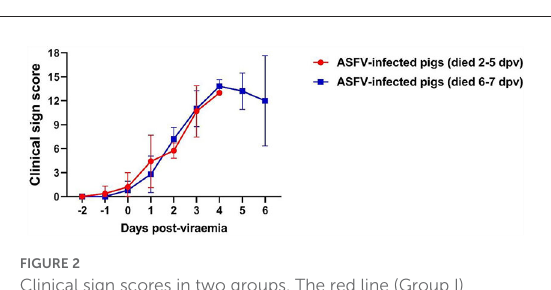
FIGURE2 Clinical sign scores in two groups. The red line (Group I) represents the pigs that died at 2–5 days post-viremia (dpv), and the blue line (Group II) represents the pigs that died at 6–7